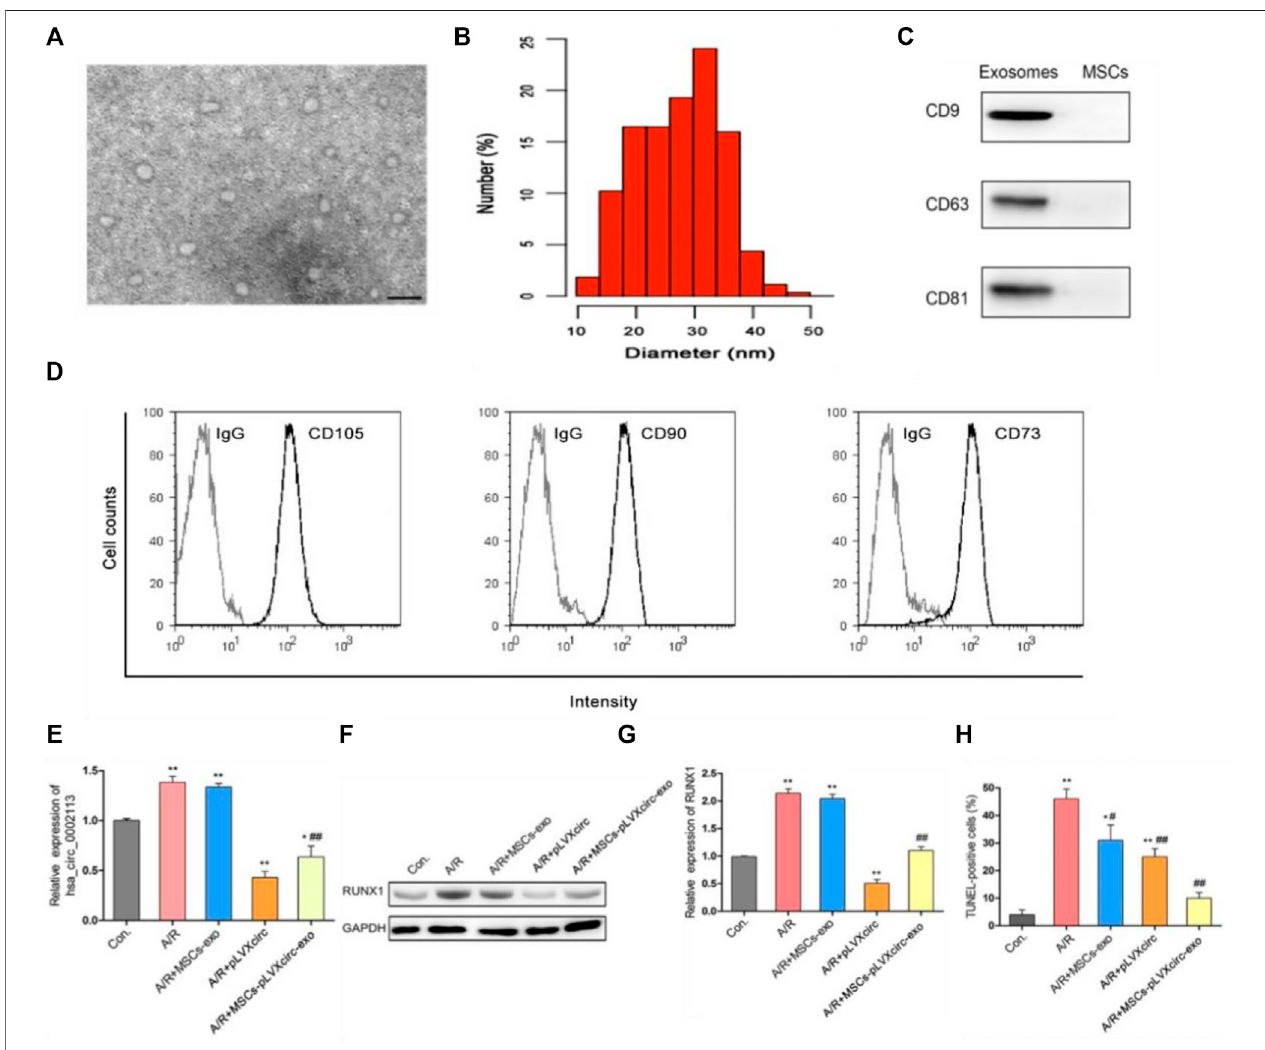
FIGURE 2 | Exosomes derived from pLVXcirc treated MSCs decreased apoptosis in A/R H9C2 cells. (A) Transmission electron microscope (TEM) of exosomes isolated from pLVXcirc treated MSCs. (B) DLS distribution of exosomes. (C) Western blot analysis of surface markers namely, CD9, CD63, and CD81 of exosomes derived from the MSCs and the control MSCs lysates ( n (cid:1) 3). (D) The surface markers CD105, CD90, and CD73 of MSCs were veri fi ed in comparison to the IgG control ** p < 0.01, compared with the control. (E) Evaluation of circRNA_0002113 expression after 1 h of anoxia/8 h of reoxygenation followed by treatment with exosomes isolated from pLVXcirc treated MSCs. (F,G) The protein expression of RUNX1 after 1 h of anoxia/8 h of reoxygenation followed by treatment with exosomes isolatedfrombonemarrow-derivedMSCs. (H,I) TUNELstainingandquanti fi cationofTUNELpositivecellsafter1 hofanoxia/8 hofreoxygenationfollowedbytreatment with exosomes isolated from pLVXcirc treated MSCs, Scale bar: 20 μ m. (J) The co-labeled RUNX1 and DAPI were estimated in H9C2 cells after 1 h of anoxia/8 h of reoxygenation followed by treatment with exosomes isolated from pLVXcirc treated MSCs, Scale bar: 25 μ m. (K) The number of RUNX1 positive cells was determined following different treatments. * p < 0.05, ** p < 0.01, compared with the control. # p < 0.05, ## p < 0.01, compared with the A/R group.